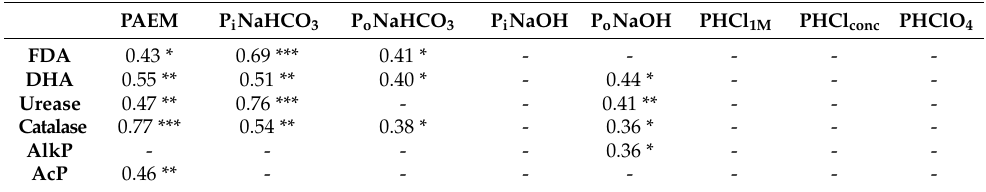
Table 8. Spearman’s correlations between P fractions and soil enzymatic activity parameters (“-”